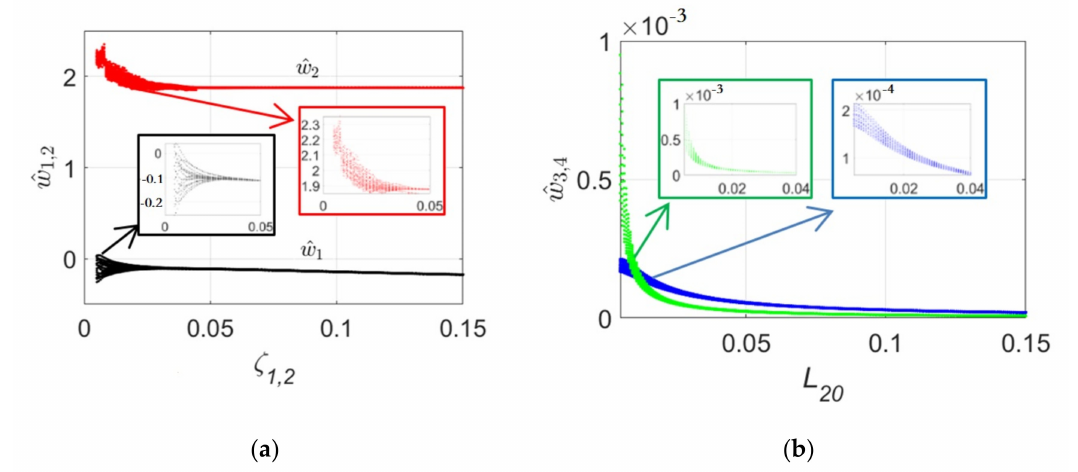
Figure 13. Bifurcation diagram of the displacement and rotation responses for varying ζ i : ( a ) dis- placement; ( b ) rotation. Black and blue line are vertical, red and green line are